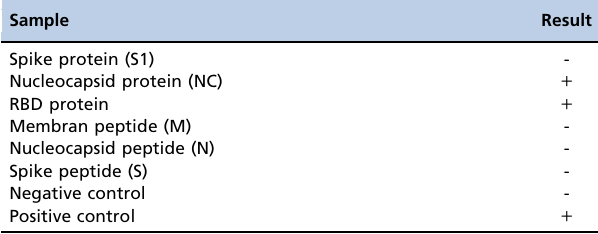
Table S1 - Detection of endotoxin in SARS-CoV-2 antigens.